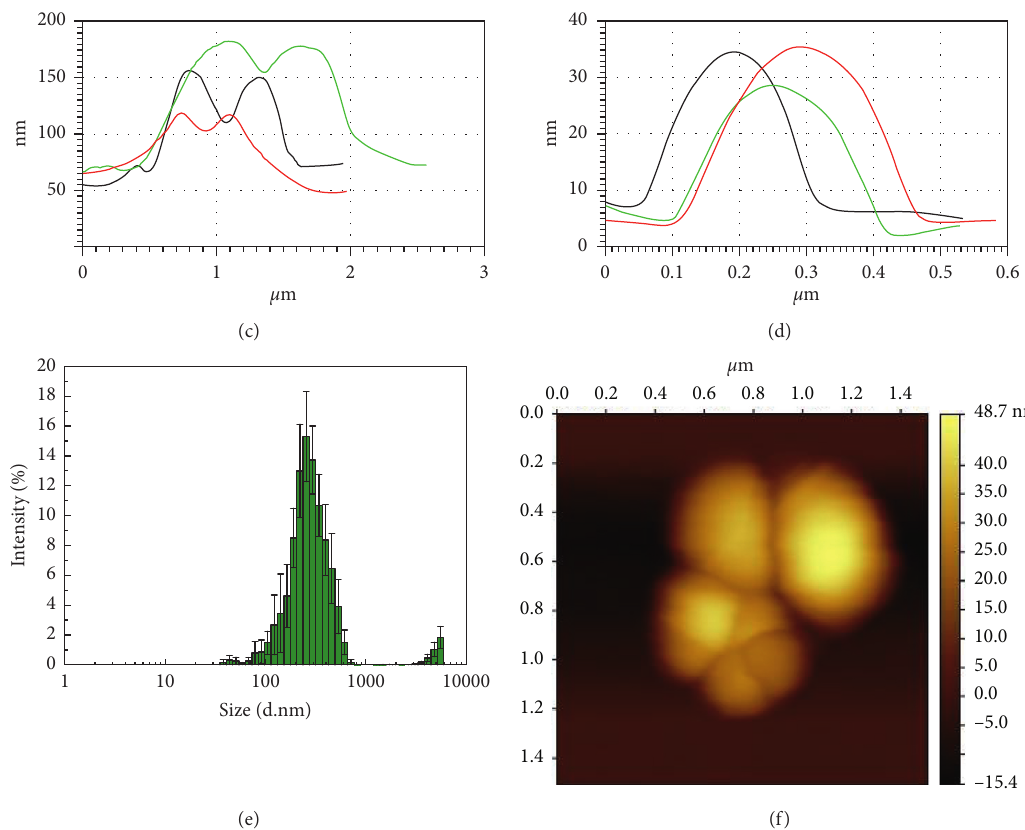
Figure 4: AFM topography image of (a) alcoholic TEC extract, (b) TEC NPs, (c, d) profile cross section (P) of lines shown in (a) and (b), respectively, (e) DLS size distribution, and (f) AFM topography image of NP aggregate.